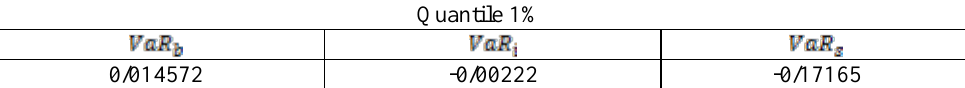
Table 5. Risk value of the three financial sectors of the bank, insurance and stock exchange